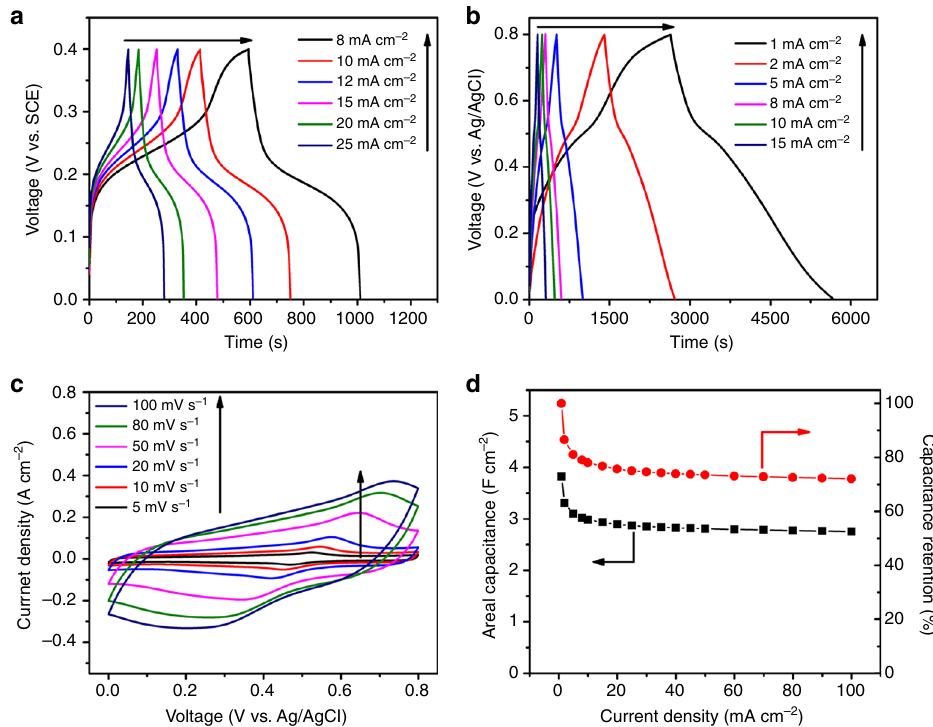
Fig. 3 Electrochemical performance of pseudocapacitive CNT/GP micro-conduit electrodes. a Galvanostatic charge/discharge pro fi les of a CNT/GP/Ni-Co hydroxide micro-conduit electrode in 2 M KOH aqueous electrolyte at different current densities in the voltage range between 0 and 0.4 V vs. SCE. b Galvanostatic charge/discharge pro fi les of a CNT/GP/PANI micro-conduit electrode in 1 M H 2 SO 4 aqueous solution at different current densities in the voltage range between 0 and 0.8 V vs. Ag/AgCl. c CV curves of the CNT/GP/PANI micro-conduit electrode at scan rates from 5 to 100 mV s – 1 with a voltage window of 0.8 V. d Areal capacitance and capacitance retention as a function of current density of the CNT/GP/PANI micro-conduit electrode calculated from charge/discharge